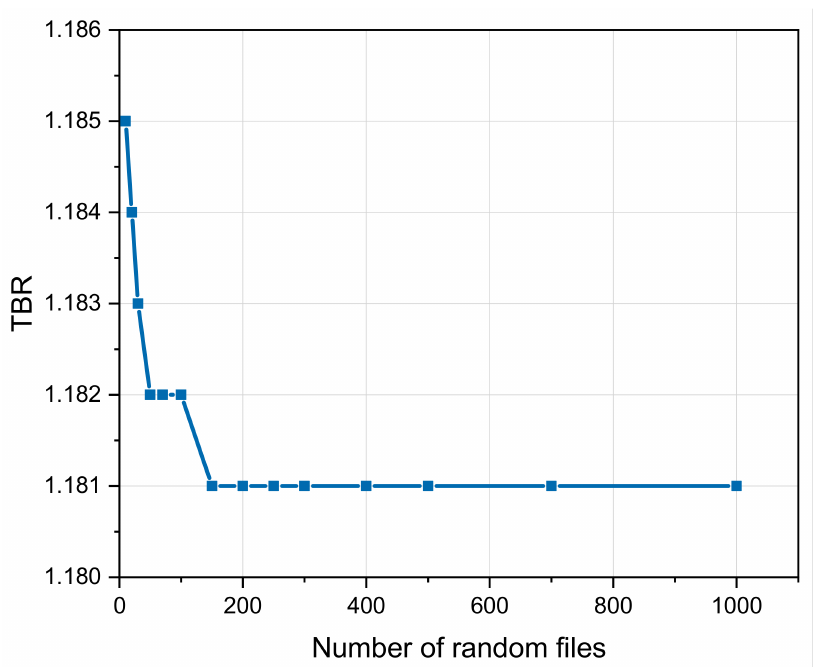
Figure 4. Results of the sensitivity calculations of the TBR as a function of the random files